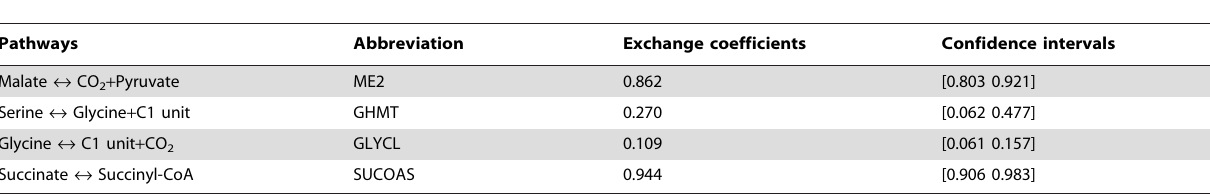
Table 2. Exchange coefficients for key metabolic pathways of